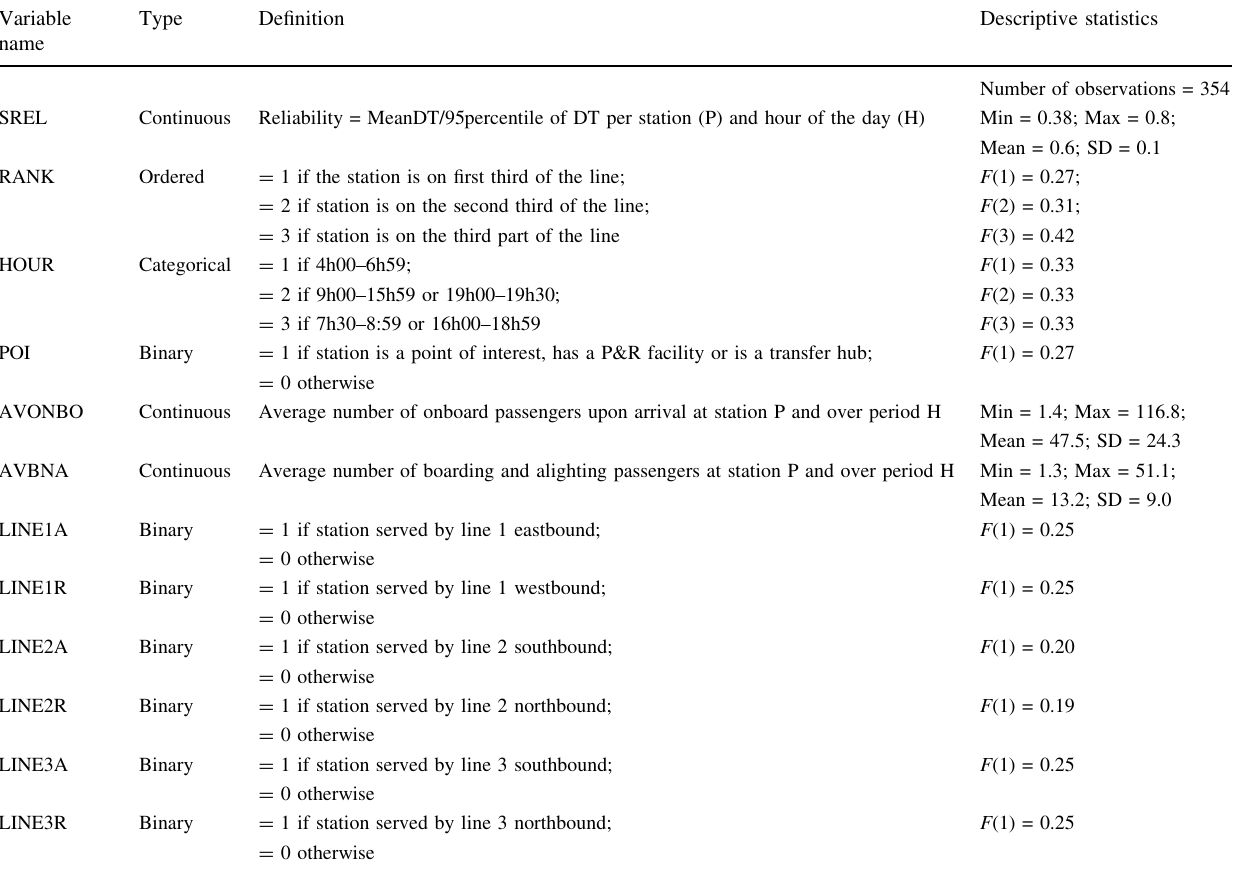
Table 3 Descriptive statistics of the dwell time reliability regression